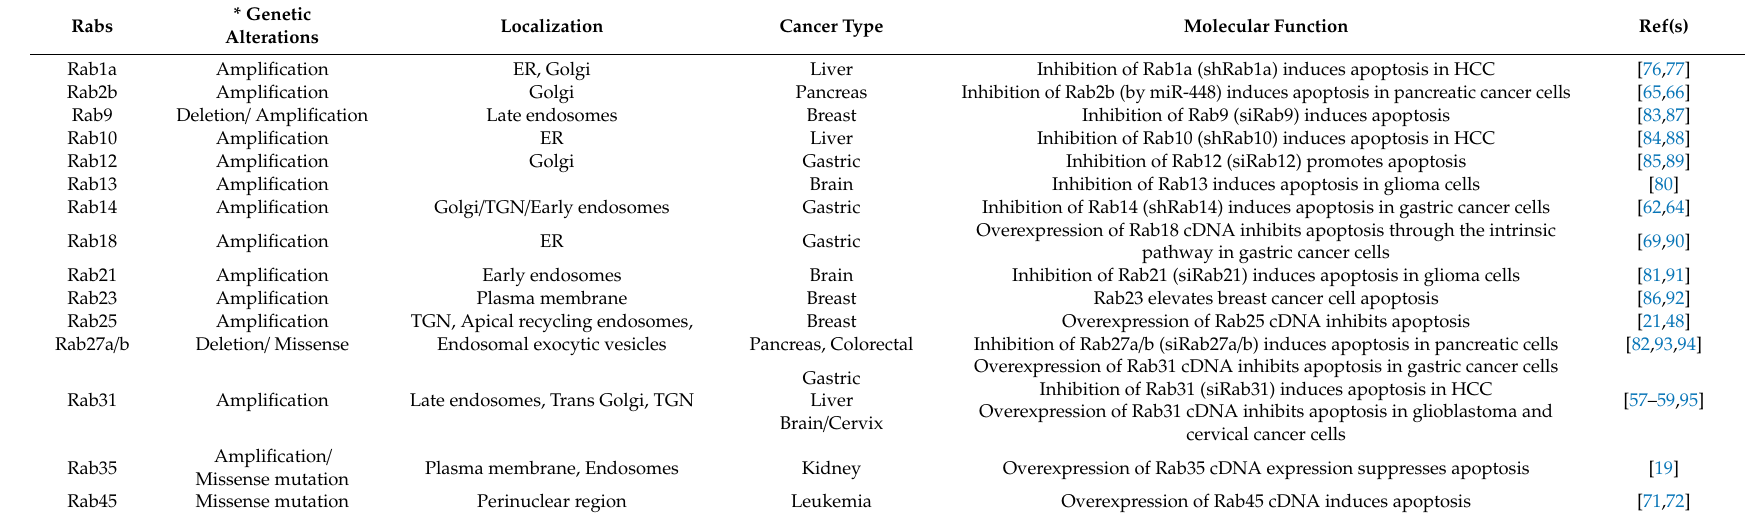
Table 1. Rab proteins involved in